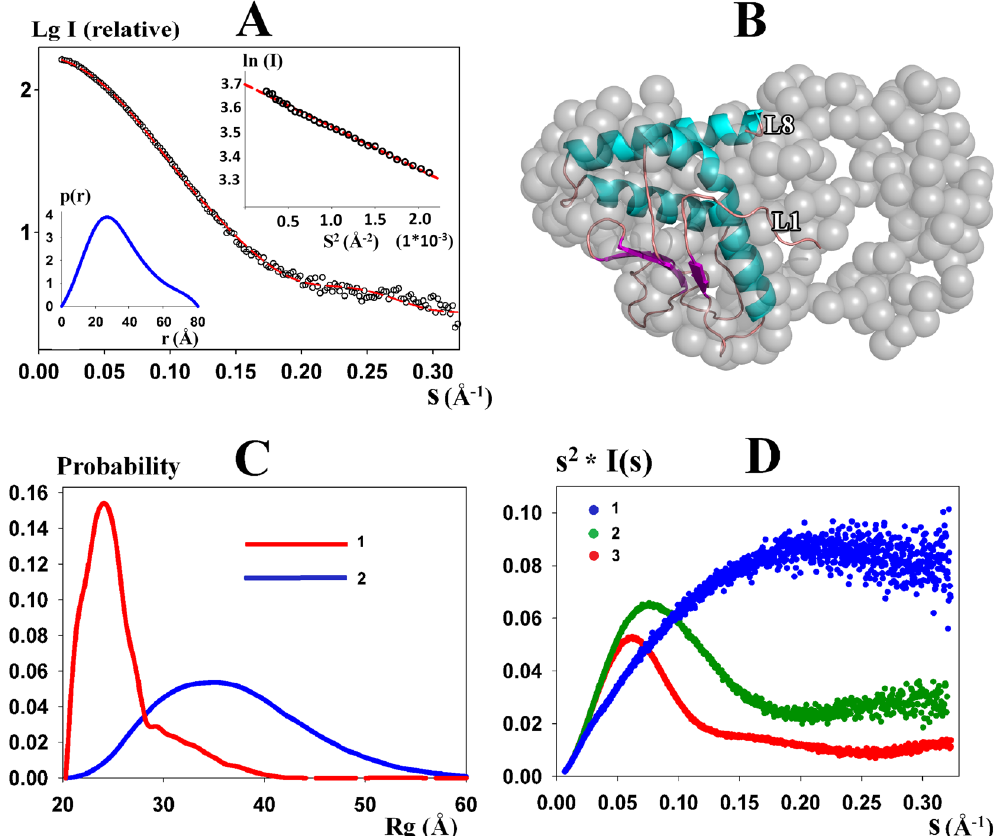
Figure 3. Solution SAXS analysis of the full-length ScWss1 protein. ( A ) Main plot - Experimental scattering data of the full-length protein (black cycles) and the scattering pattern computed from the GASBOR model (red dashes); Insert (left below) - Distance distribution function p ( r ) of the full-length ScWss1 protein; Insert (right above) – Guinier plot for the full-length protein. ( B ) Superposition of the GASBOR model and the crystallographic structure of ScWss1 21-148 . ( C ) Rg distribution of the optimized ensemble (curve 1) selected from a random pool (curve 2) for the full-length ScWss1 analyzed by program EOM. ( D ) 1 - Kratky plot of a flexible protein (EG5 repeat protein G51-G52); 2 - Kratky plot of the full-length ScWss1; 3 - Kratky plot of a folded protein (BSA).